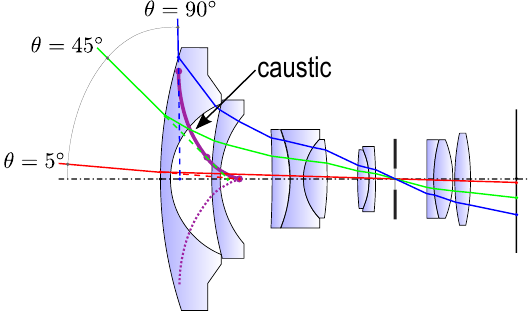
Figure 4: Schematical raytracing of a fisheye